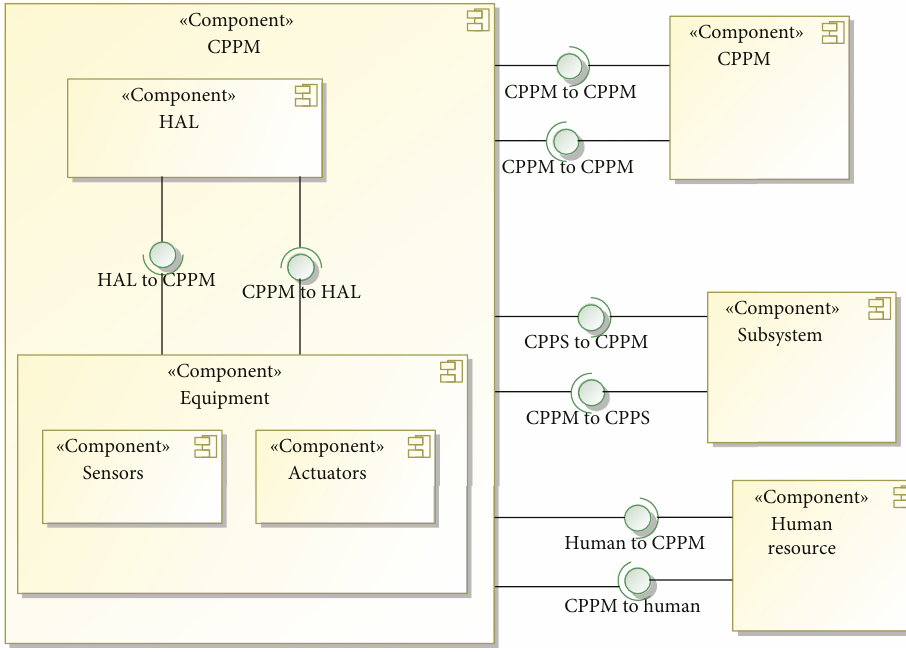
Figure 2: CPPM structural model (adapted from [16]).